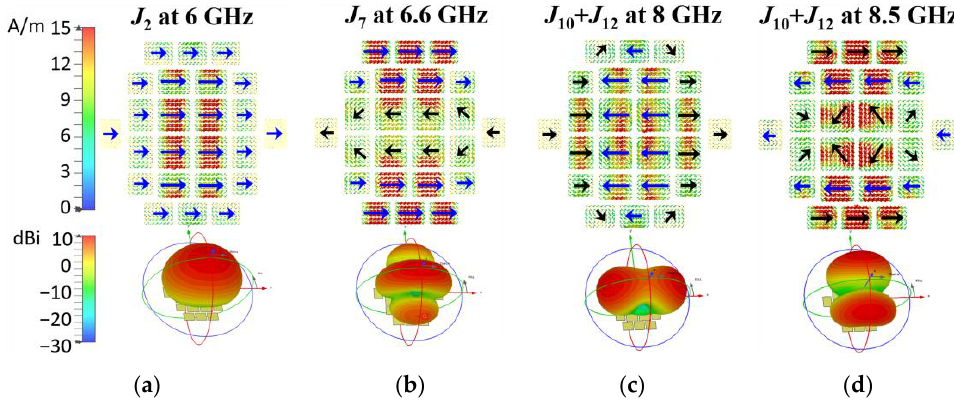
Figure 5. Modal currents J n ( ω ) and radiation patterns of MTS2 at the resonant frequencies and at the upper frequency ends (8.0 and 8.5 GHz). ( a ) Mode 2 at 6.0 GHz, ( b ) Mode 7 at 6.6 GHz, ( c ) Mode 10 + 12 at 8.0 GHz, and ( d ) Mode 10 + 12 at 8.5 GHz.